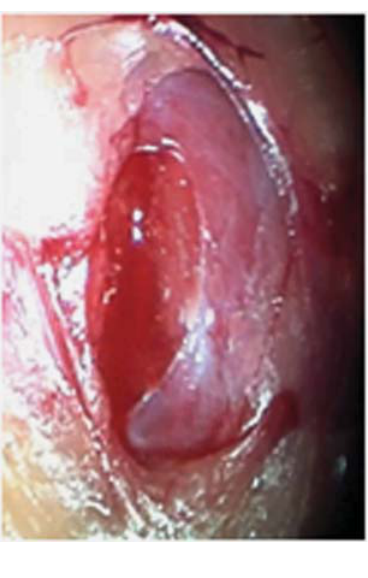
Figure 3 - Aspect of kidney surface after a tissue sample was taken, with only minimal